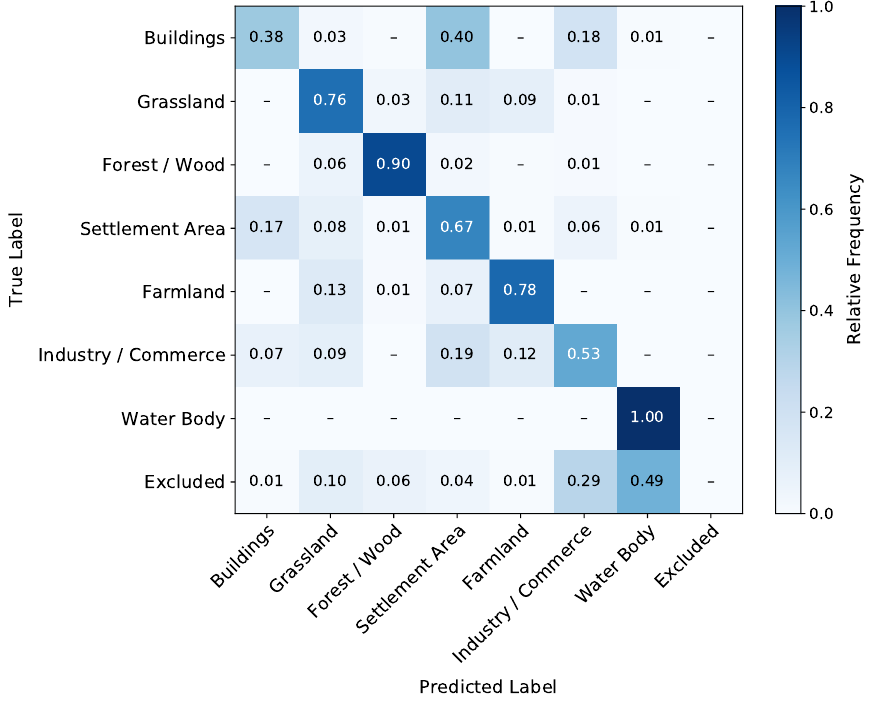
Figure 7. Normalized confusion matrix for the best-scoring ensemble of FCN B models. The prediction is performed on the test subset of the 2016 data and compared to the